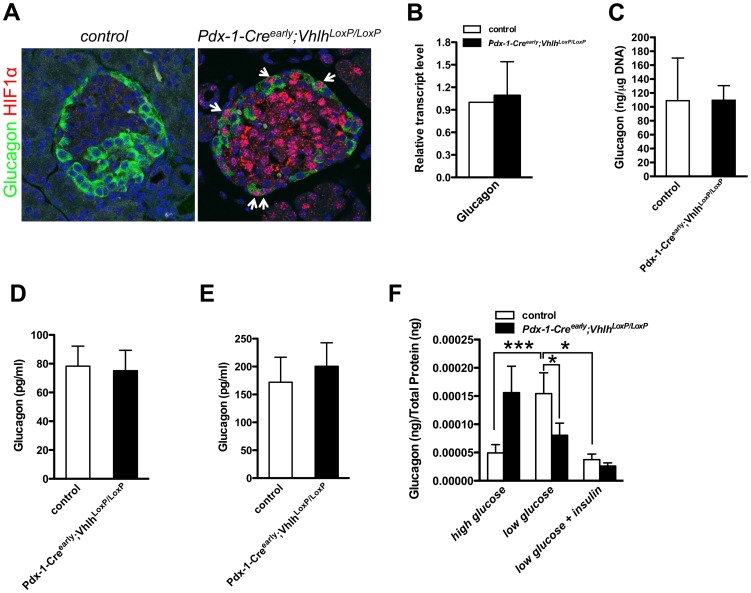
VHL inactivation impairs glucagon secretion.
A. Robust HIF1α accumulation is evident in glucagon-expressing cells (arrowheads) of Pdx-1-Creearly;VhlhLoxP/LoxP mice. B. Glucagon expression, as quantified by quantitative PCR in islets isolated from control or Pdx-1-Cre;VhlhLoxP/LoxP animals (n = 3), was unchanged. Error bars represent standard deviation. C. Total glucagon content of islets is comparable between the two groups (n = 4). Error bars represent standard deviation. D. Circulating plasma glucagon in fed conditions is similar between control (open bars, n = 6) and Pdx-1-Creearly;VhlhLoxP/LoxP (black bars, n = 6) mice. Error bars represent standard error of the mean. E. Circulating plasma glucagon after an overnight fast is similar between control (open bars, n = 8) and Pdx-1-Creearly;VhlhLoxP/LoxP (black bars, n = 7) mice. Error bars represent standard error of the mean. F. Incubation of isolated islets in high followed by low glucose concentration led to glucagon secretion from control islets (n = 20-21), while Pdx-1-Creearly;VhlhLoxP/LoxP islets appeared blocked in their ability to secrete glucagon (n = 21). *p<0.05, ***p<0.0005. Exogenous insulin (17 nM) led to a reduction in the glucagon secretion response from the control islets (n = 8) in the presence of low glucose but had no significant effect on the mutant islets (n = 8). Error bars represent standard error of the mean.